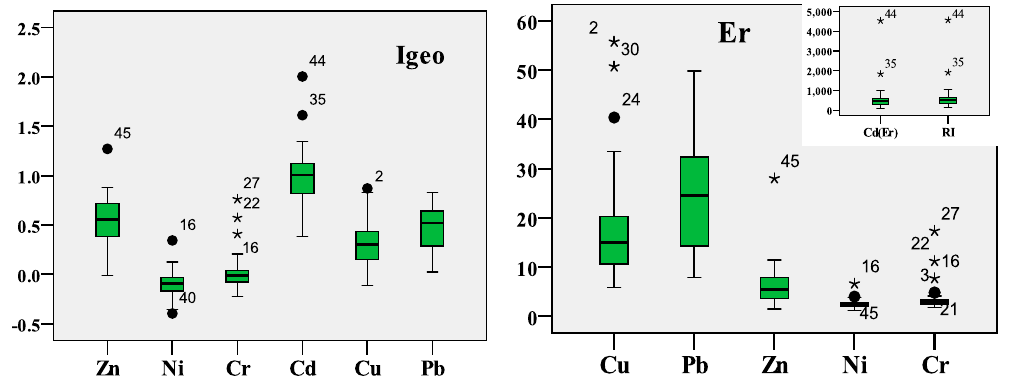
Figure 6. Box charts for accumulation index and potential hazard index.